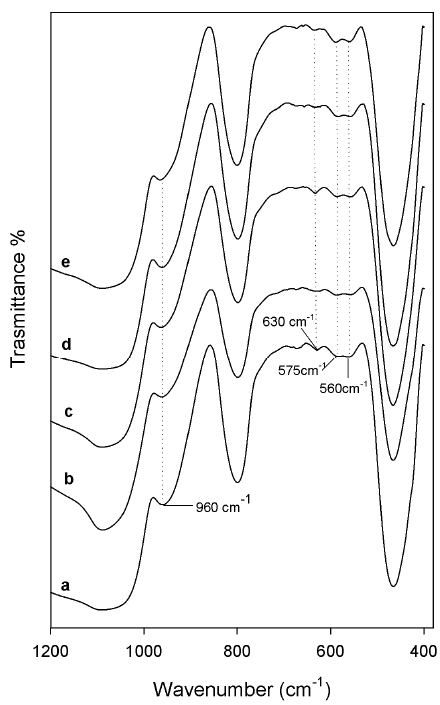
Figure 4. FT-IR spectra of ( a ) pure SiO 2 ; ( b ) SiO 2 /CGA, 5 wt%; ( c ) SiO 2 /CGA, 10 wt%; ( d ) SiO 2 /CGA, 15 wt%; and ( e ) SiO 2 /CGA, 20 wt% after 21 days of exposure to SBF.